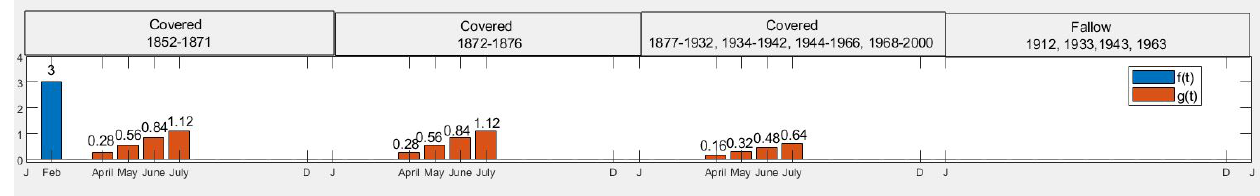
Figure 8. Hoosfield barley experiment. Scenario 3: farmyard manure 1852–1871 and nothing thereafter.